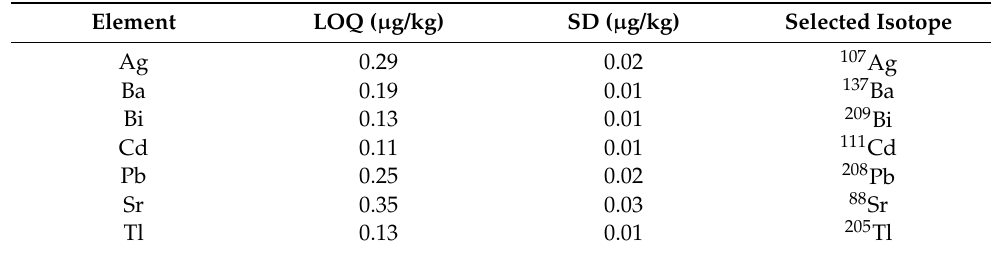
Table 3. Determined limits of quantification (LOQ) ( µ g/kg) by the ICP-ToF-MS technique for the studied